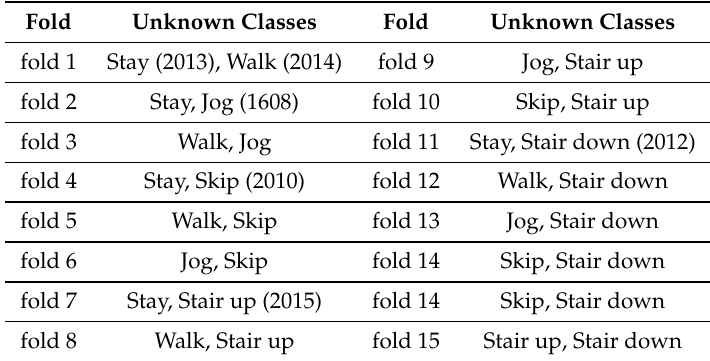
Table 4. Foldings of the HASC classes. The values in the parenthesis is number of instances of each class.